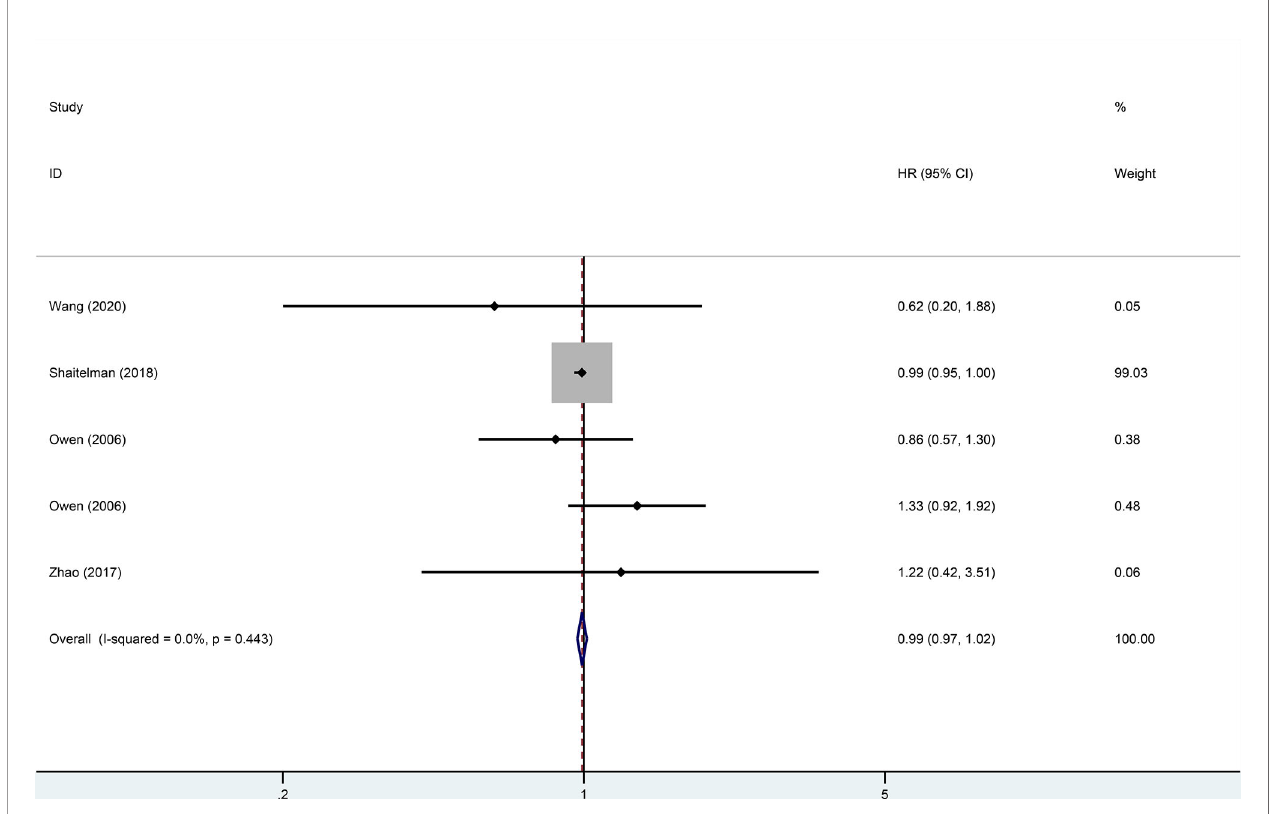
FIGURE 2 | Forest plot of hypofractionated radiotherapy (HFRT) vs . conventional radiotherapy (CFRT) for local recurrence ( p =